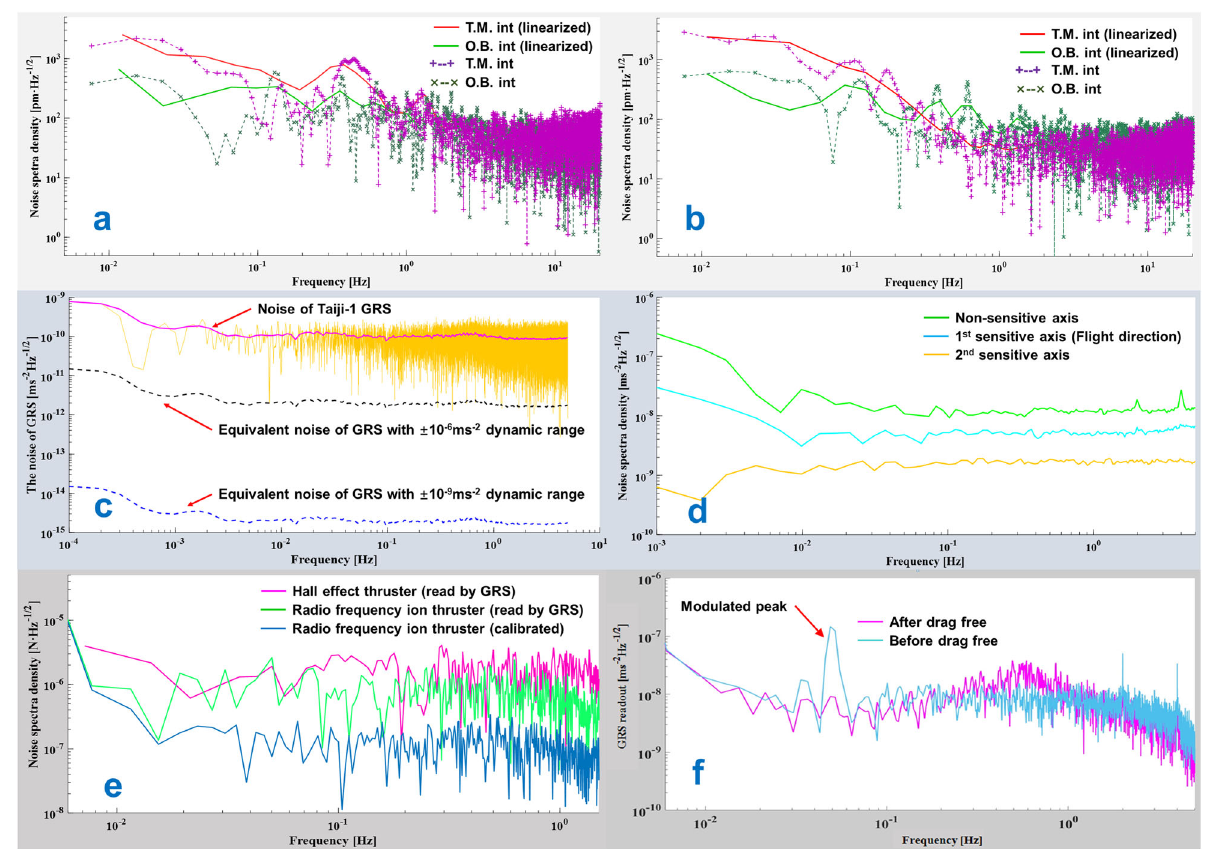
Fig. 2 On-orbit test results of Taiji-1 payload. a The precision of optical bench interferometer (O.B. int) and test mass interferometer (T.M. int) by using the fi rst laser. b The precision of the two primary interferometers (using second laser). c The noise of Taiji-1 ’ s gravitational reference sensor (GRS) and the equivalent noise of the GRS corresponding to smaller dynamic ranges. d The acceleration of the Taiji-1 satellite in three axes readout by GRS. e The noise from the two types of thrusters readout by the GRS and the calibrated noise of the radio frequency ion thruster. f The gravitational wave readout in spectrum density before and after the drag-free